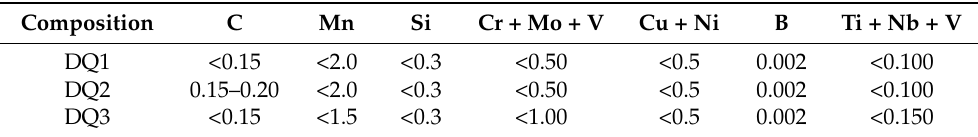
Table 1. Chemical composition ranges of three direct quenched, ultra-high strength hot rolled steels. (All in wt %, balance: Fe + impurities). Measured via Optical Emission Spectroscopy, except C, N, and S via